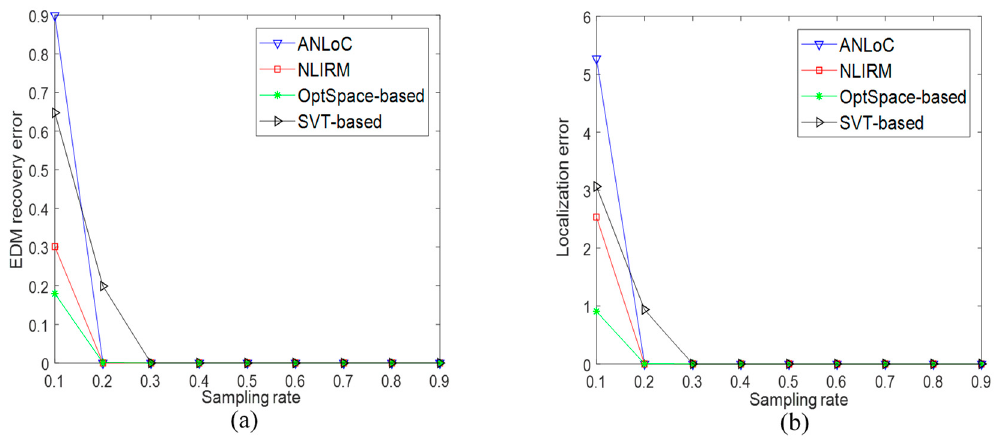
Figure 3. Performance comparison under scenario 1 without the noise and anomaly. ( a ) EDM recovery error and ( b ) localization error.